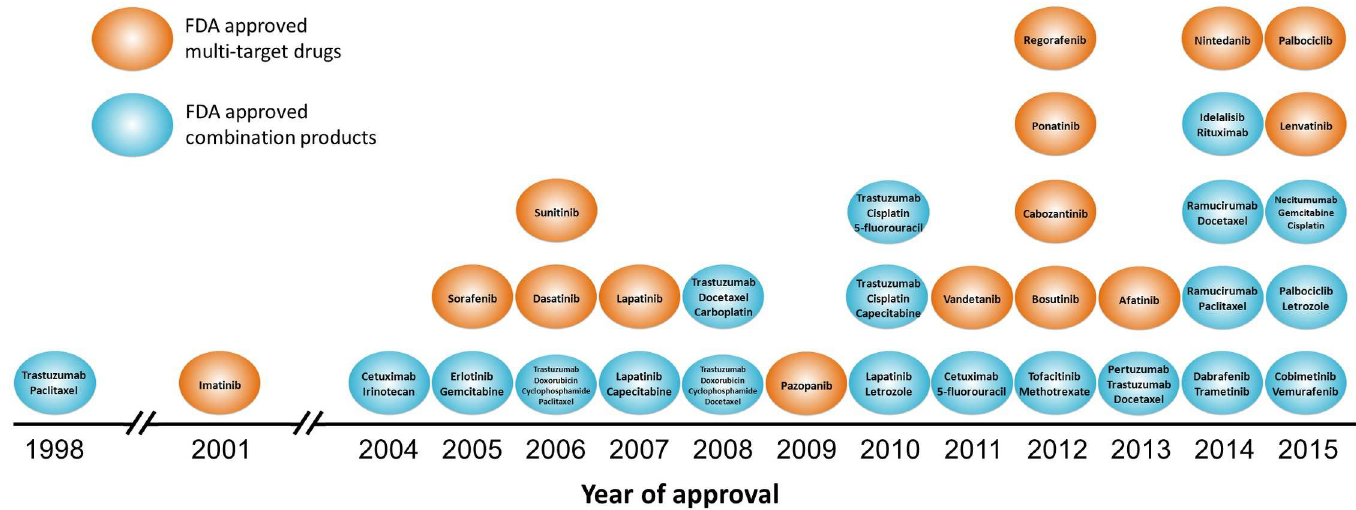
Fig 1. The approval timeline of FDA approved multi-target drugs and combination products against the human